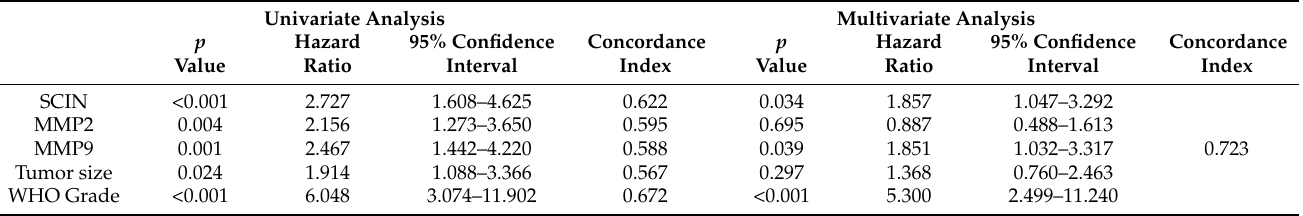
Figure 6. The expression of SCIN is correlated with MMP2/9. ( A ) Western blot images and analyses of SCIN expressed in 6 normal and 37 glioma tissues (* p < 0.05. *** p < 0.001). ( B ) Western blot images and analyses of MMP2 expressed (* p < 0.05. *** p < 0.001). ( C ) Western blot images and analyses of MMP9 expressed (** p < 0.01. *** p < 0.001). ( D , E ) Correlation analysis between SCIN and MMP2/9 in our clinical tissues (r = 0.6848, p < 0.001 and r = 0.6218, p < 0.001, respectively). Table 2. Univariate and multivariate analyses of various prognostic parameters in patients with gliomas.